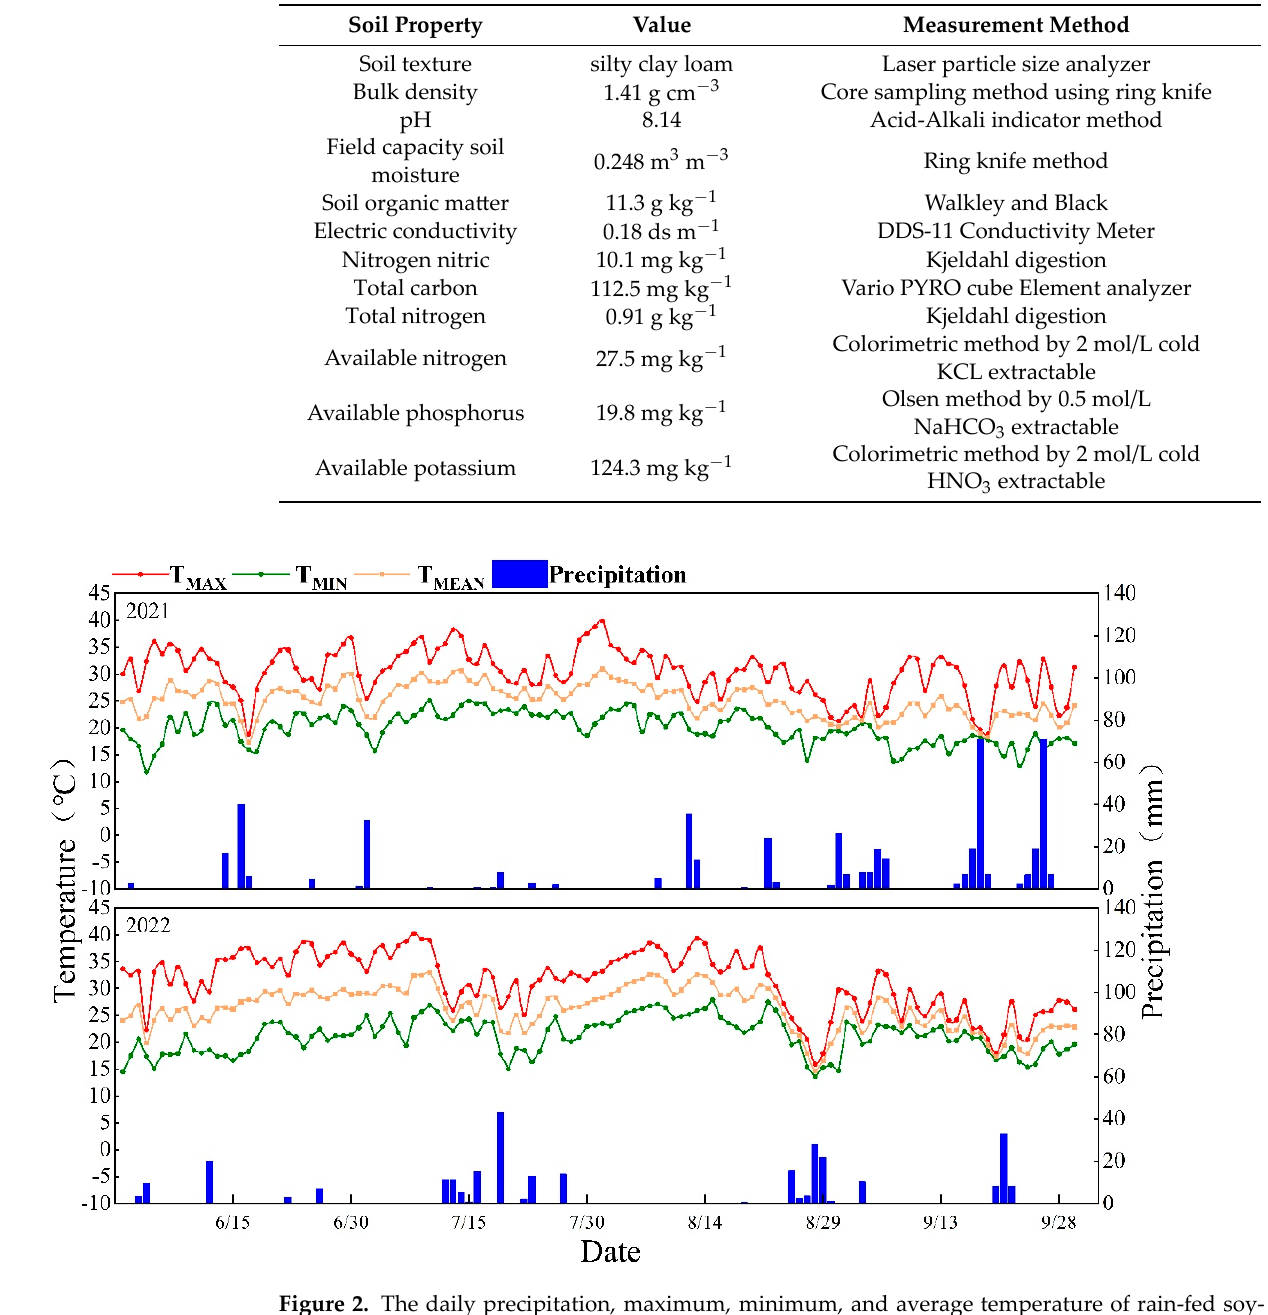
Figure 2. The daily precipitation, maximum, minimum, and average temperature of rain-fed soy- bean growing season in 2021 and 2022.